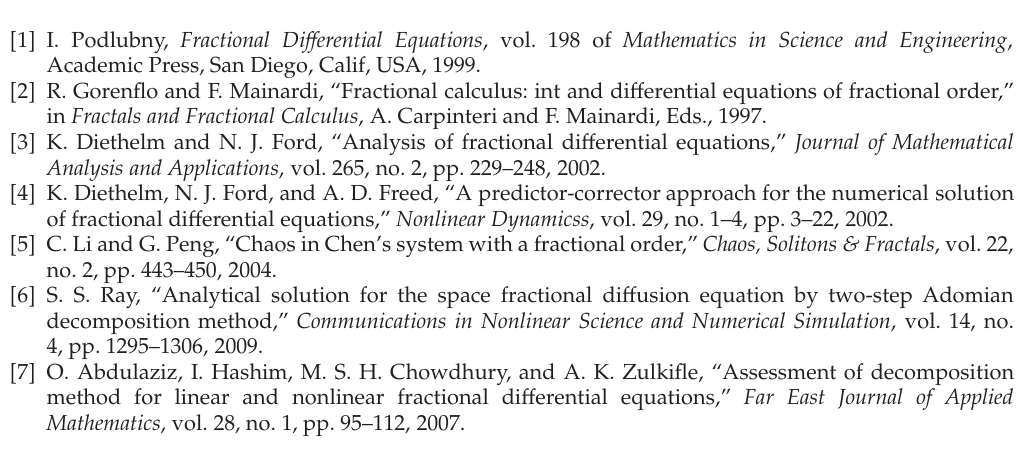
(cid:9) 0 . 25 using fifth (cid:0)